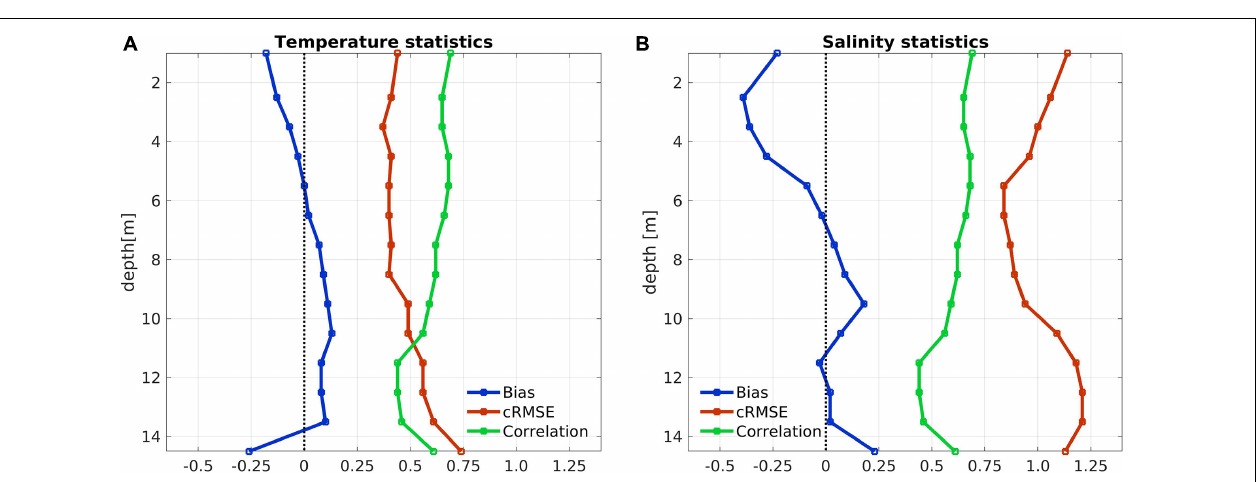
FIGURE 8 | Vertical distribution of model error statistics: (A) water temperature and (B)